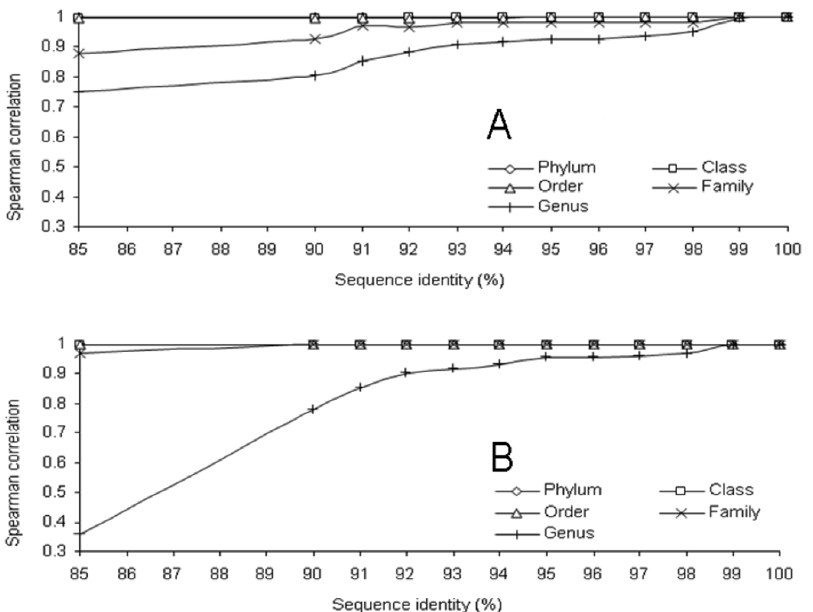
Figure 2. Correlation between the composition of the initial dataset (no clustering) and the composition based on the classification of the consensus OTUs (80% bootstrap value) clustered at various sequences identity and taxonomic levels. A: SARST method and B: 454 method.